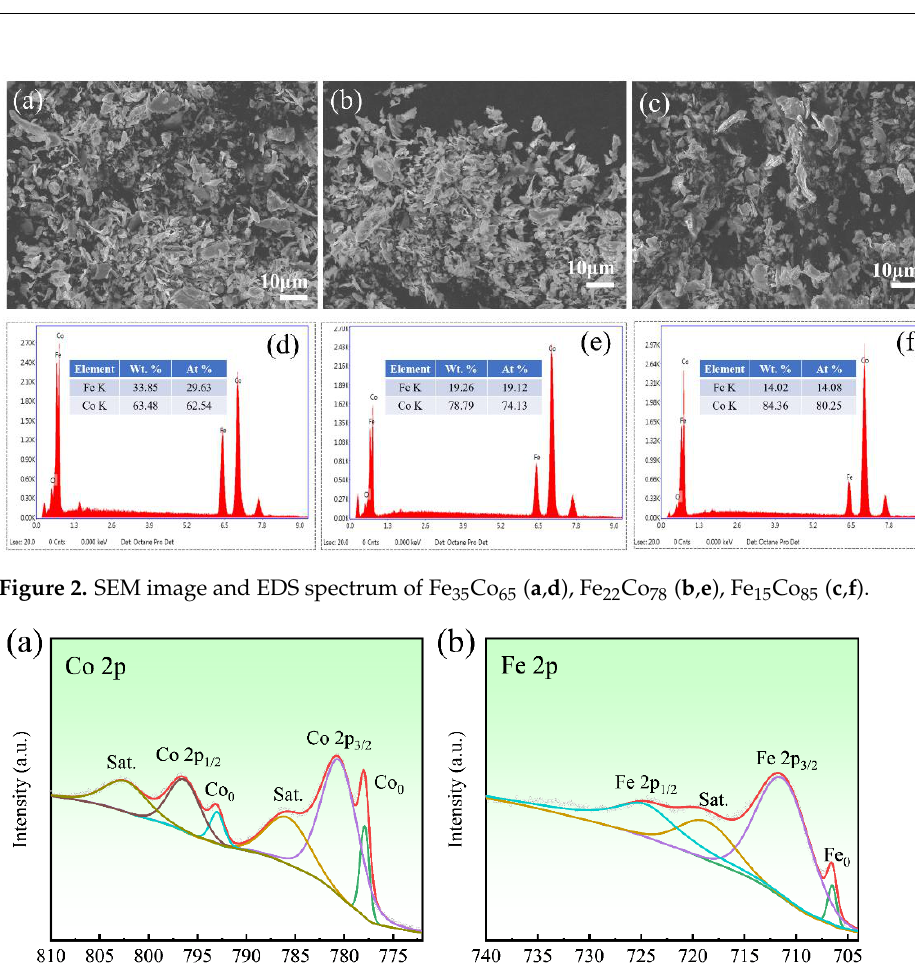
Figure 3. XPS spectra of ( a )Co 2p and ( b )Fe 2p of Fe 35 Co 65 sample.